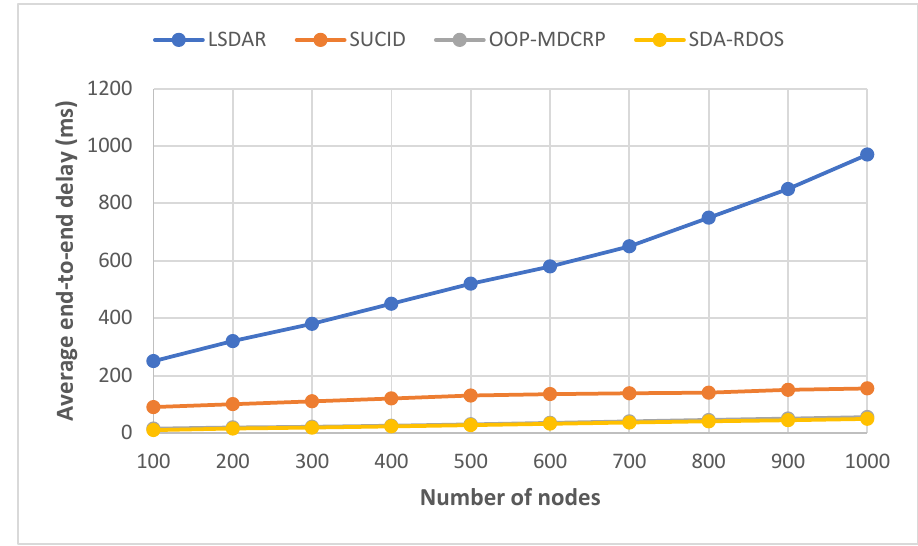
Figure 18. Average Delay Analysis of LSDAR, SUCID, OOP ‐ MDCRP, and SDA ‐ RDOS protocols.